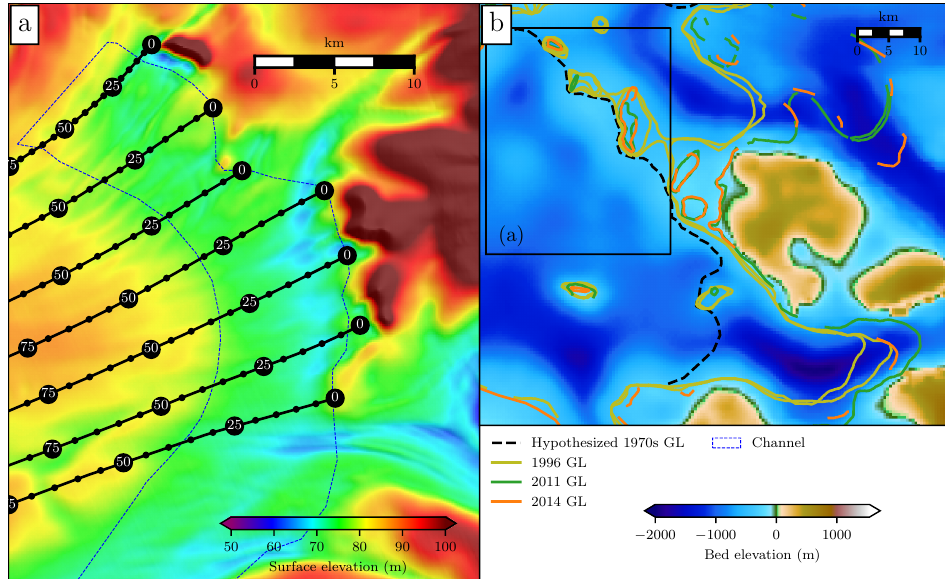
Figure 6. (a) Detail of Dotson surface trough (region outlined in blue). Solid black lines show flow lines calculated from the 1996 velocity, with dots placed every 5 years. Large black circles are spaced every 25 years and labeled with age in years. Background is 2012 surface elevation. (b) A possible location of the grounding line before recent retreat (black dashed line). This position is illustrative only, but shows a location that would have been susceptible to a retreat that would have increased melt rates and grounding-line flux. Other lines show grounding-line positions as above. Black box shows location of panel (a) . Background is bathymetry (Millan et al.,